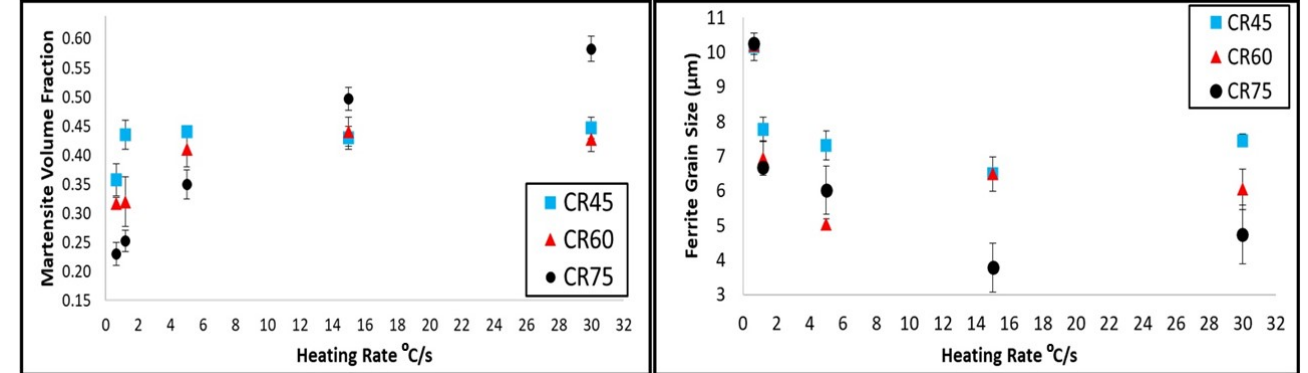
Figure 5. Effect of the heating rate on the martensite volume fraction and ferrite grain size for all the cold reductions in Variant 1.